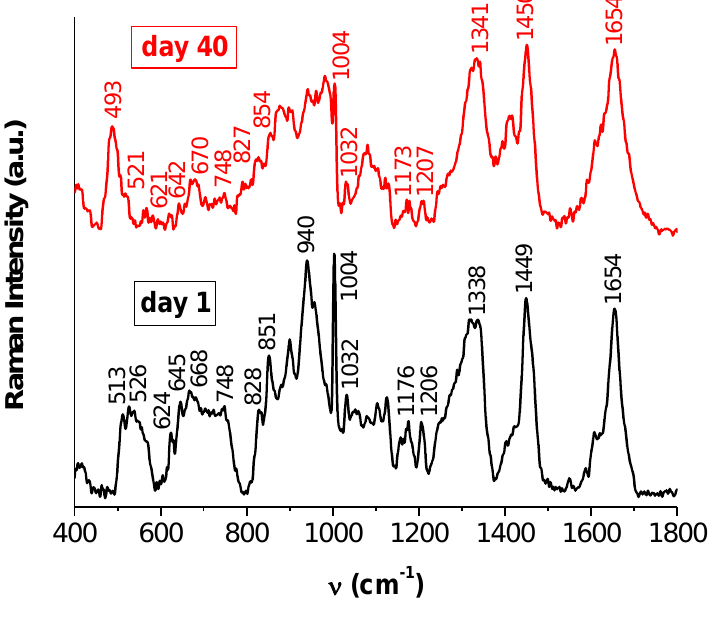
Figure 5. Raman spectra of BSA (20 mg/mL) prior to (day 1) and after (day 40) gold nanoparticle formation; peak positions are marked; [HAuCl 4 ] = 4 × 10 − 2 M.